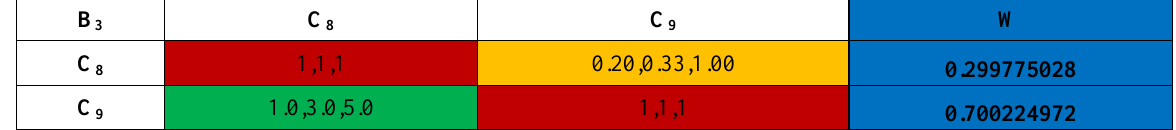
Table 7. The pairwise matrix, B